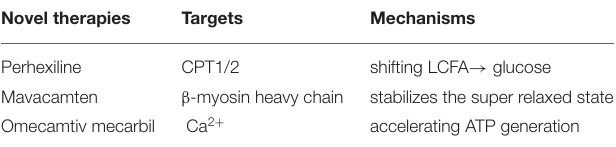
TABLE 3 | Table for metabolic therapy. Novel therapies Targets Mechanisms